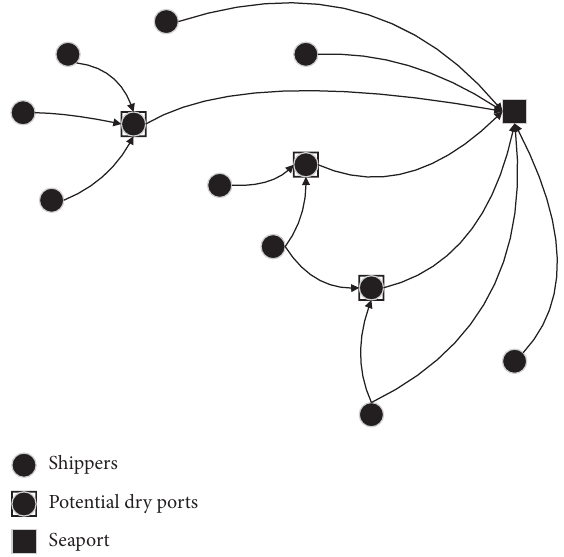
Figure 1: A simple diagram of an inland container transportation network. Table 2: The parameters and variables and their